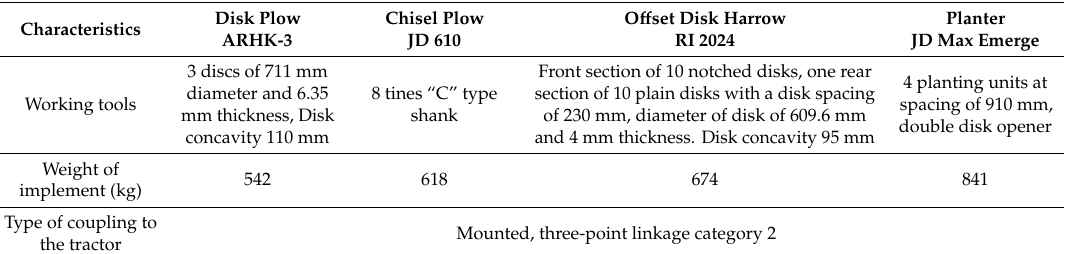
Table 2. Characteristics of the implements used for the tillage